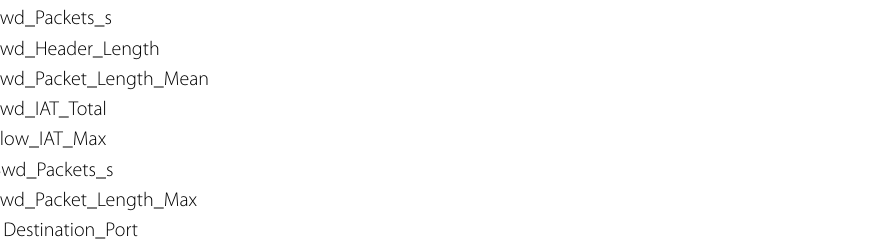
Table 10 Features appearing in at least 5 out of 7 rankings of CSE-CIC-IDS2018, referred